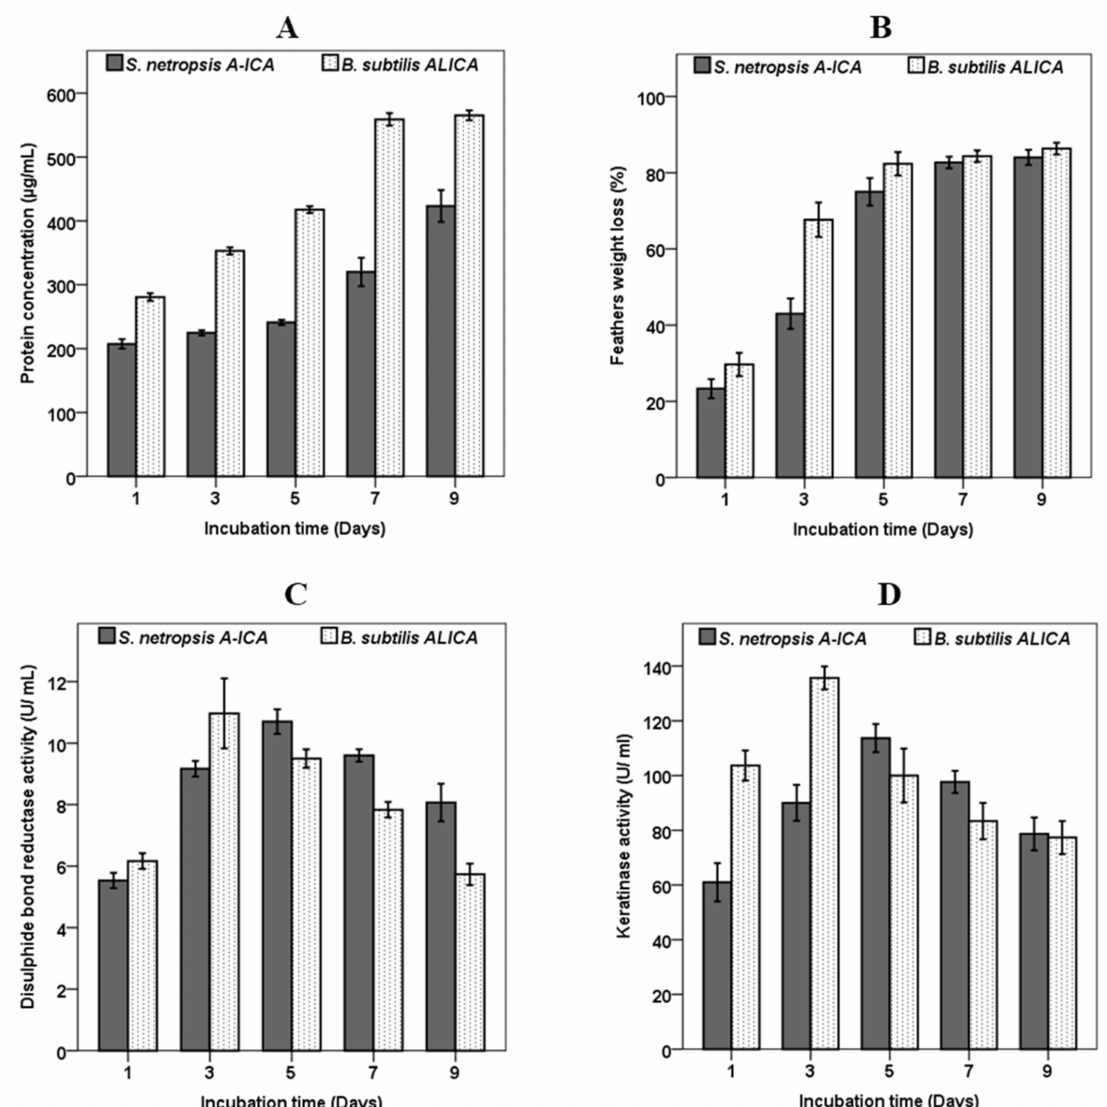
Figure 3. Total protein concentration ( A ), feather weight loss ( B ), and disulphide bond reductase activity ( C ), and keratinase activity ( D ) by S. netropsis A-ICA and B. subtilis ALICA separately, in the basal feather medium during 9 days of